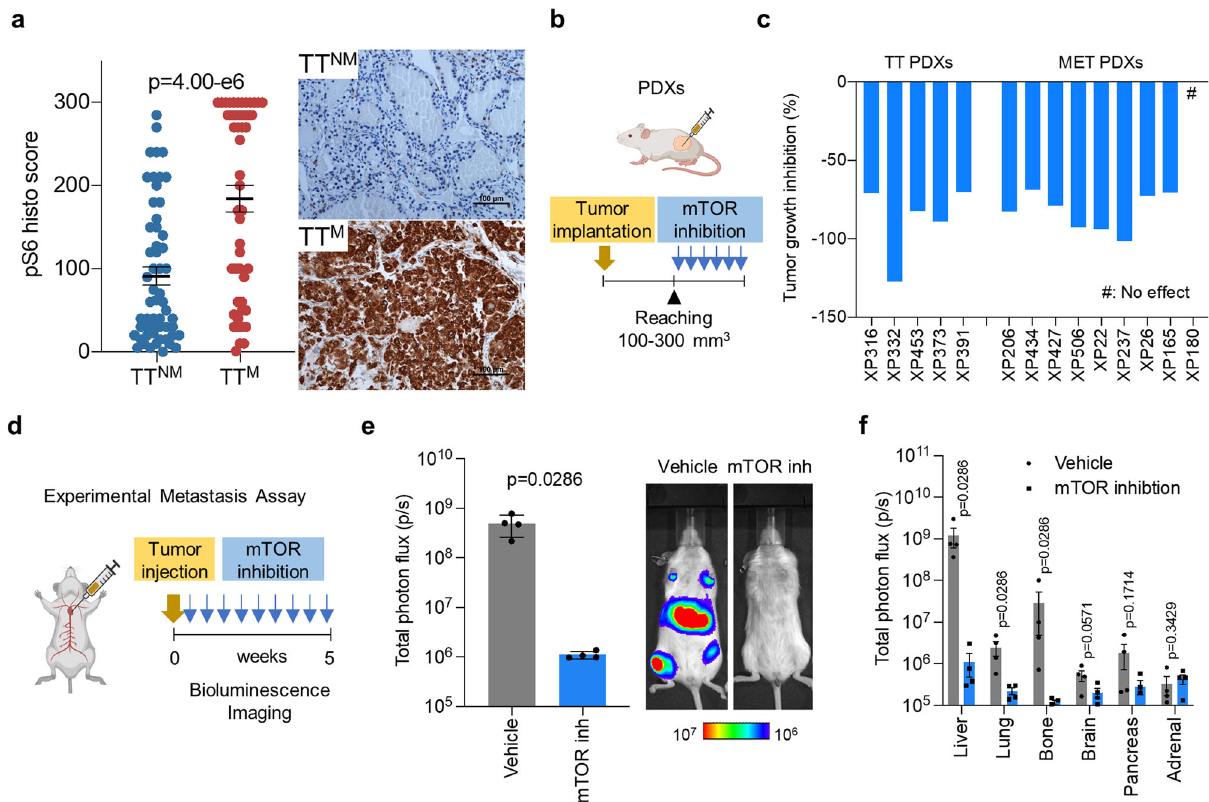
Fig. 6 mTOR signaling is induced in metastatic tumor thrombus. a Quanti fi cation (left) and representative immunohistochemistry images (right) of phospho-S6 in TT NM and TT M ( n = 65 patients, 81 samples). Data are presented as scatter dot plots and lines are at mean values ±SEM. Two-sided unpaired Student t test. b Schematic highlighting experimental protocol to inhibit mTOR in RCC patient-derived xenografts (PDXs). c Tumor growth inhibition rates of TT- and metastasis-derived PDX lines by mTOR inhibitor sirolimus (3 – 5 mice for each PDX). d Schematic of experimental protocol to inhibit mTOR in experimental metastasis assay. e , f Luciferase transduced 786-O ccRCC cells were intracardially injected and metastatic incidence was tracked by whole-body bioluminescent imaging (BLI: Total photon fl ux (p/s)) in mice treated with either vehicle or everolimus daily by oral gavage. BLI quanti fi cation and representative images of whole-body are shown ( e ). Quanti fi cation of metastatic burden in organs by ex vivo imaging ( f ). n = 4 mice each group. Data are presented as mean ± SD. Two-tailed Mann – Whitney U -test.